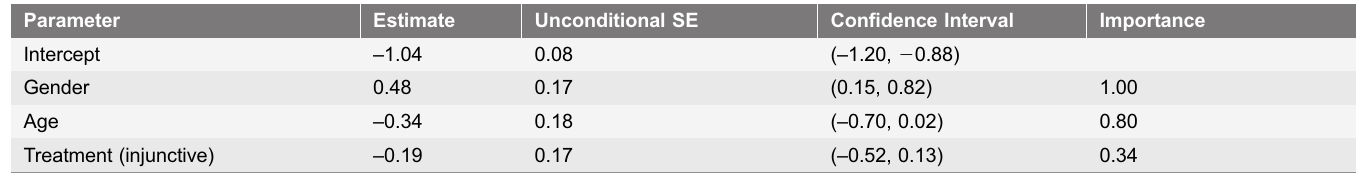
Table 7. Estimates, unconditional standard errors, confidence intervals and relative importance for parameters included in the top models for Table 6.